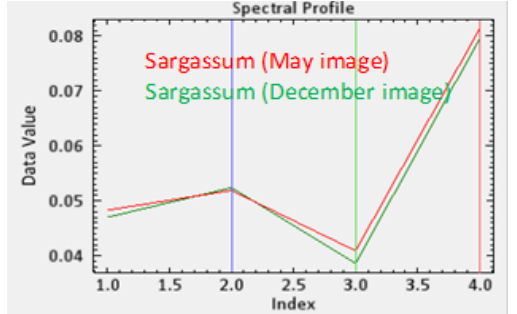
Figure 3. Spectral profile of Sargassum